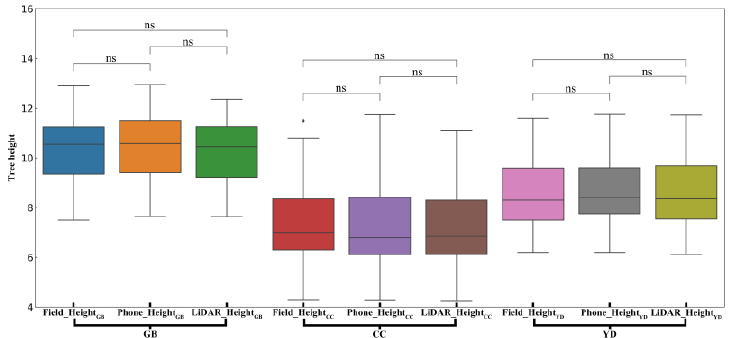
Figure 12. Intergroup analysis of three tree species and three tree height-extraction methods. ns means